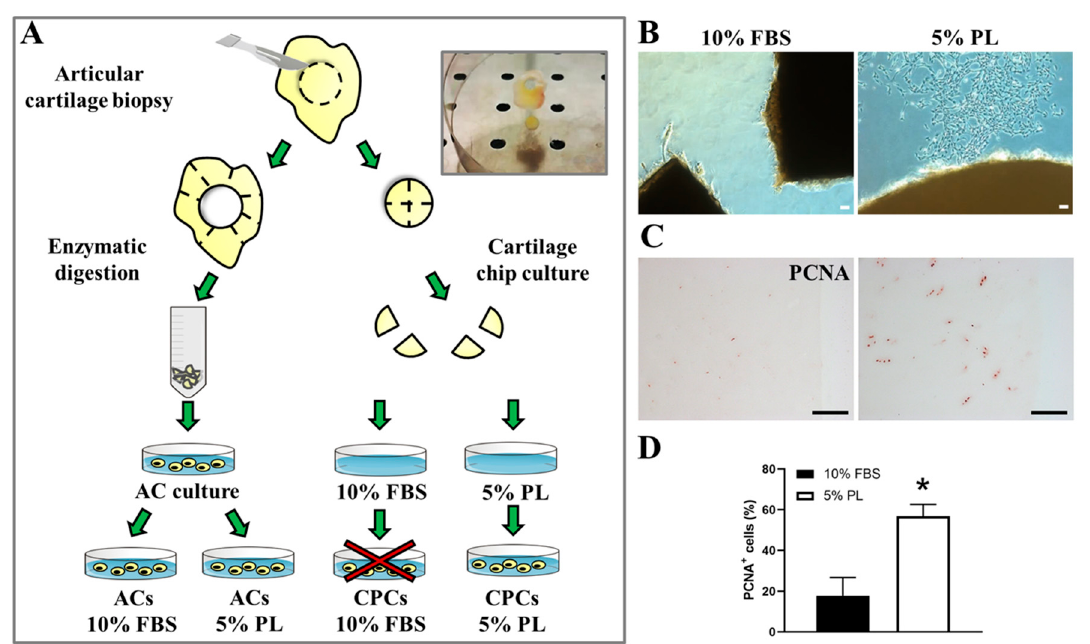
Figure 1. Experimental design of cell cultures (articular chondrocytes (ACs) and chondro-progenitors (CPCs) from human articular cartilage biopsies. ( A ) Representative illustration of biopsy handling to obtain ACs culture and cartilage chip culture. ( B ) Optical images of cartilage chips after 15–20 days in culture with cells coming out to the medium supplemented with platelet lysate (PL) versus fetal bovine serum (FBS) and ( C ) representative immunohistological distribution of proliferating cell nuclear antigen (PCNA)-positive cells inside tissue in both culture conditions ( N = 3). ( D ) Histogram showing the percentage of PCNA-positive cells in cartilage chips maintained in culture with FBS or PL. Data are represented as mean ± SEM ( N = 3, * p < 0.05 versus ACs 10% FBS by Student’s t -test analysis). All scale bars correspond to 100 µm.